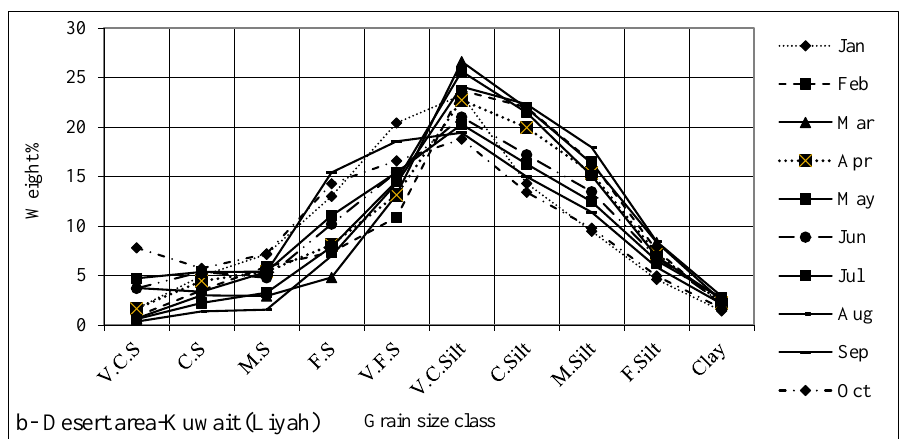
Figure 18. Temporal variations of grain size percentages of dust in Kuwait within the coastal ( a ) and the desert ( b ) areas downwind from the two SDS hotspots. (V.C.S.: Very Coarse sand; C.S.: Coarse sand; M.S.: Medium sand; F.S.: Fine sand; V.F.S: Very fine sand; V.C.Silt.: Very coarse silt; C. Silt: Coarse silt; M.Silt: Medium silt; F.Silt: Fine silt; V.F.Silt: Very fine silt).